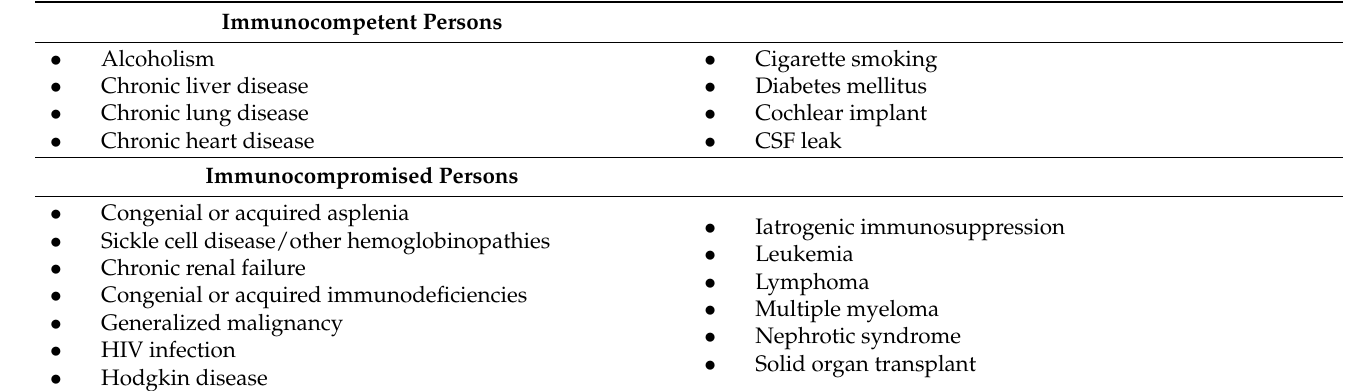
Table 2. Medical indication